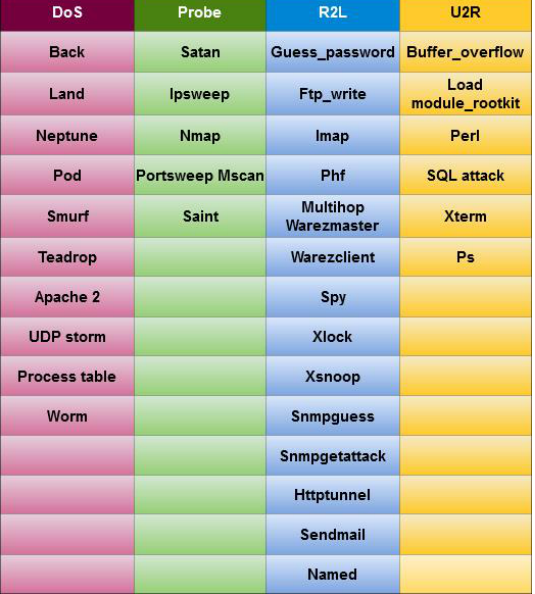
Figure 6. NSL-KDD dataset.